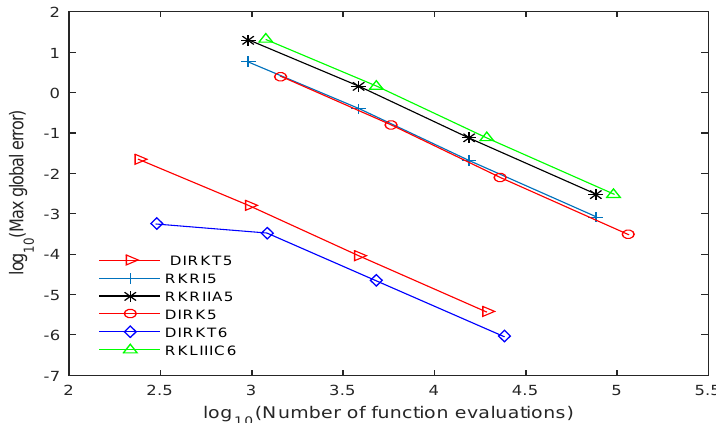
Figure 2. Accuracy curve for Problem 2 for DIRKT5, DIRKT6, DIRK5, RKRI5, RKRIIA5 and RKLIIIC6 methods with h = 0.1,0.025,0.00625,0.00125.